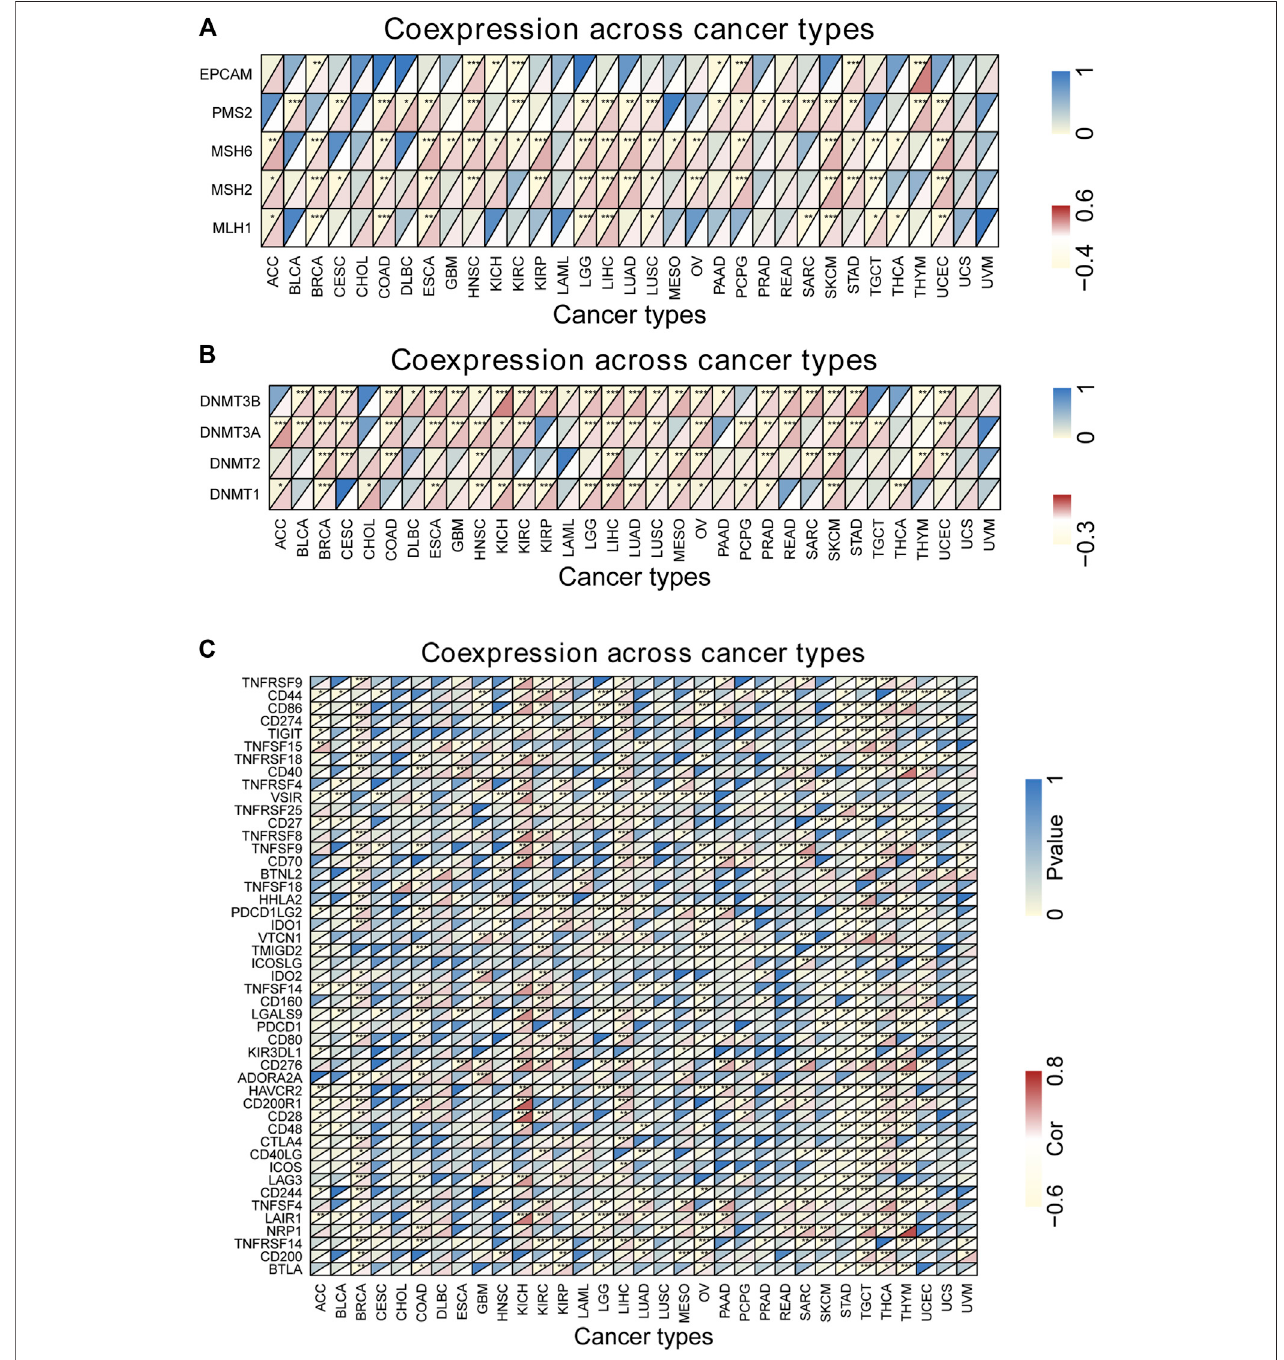
FIGURE 7 | Co-expression analysis between DUXAP8 expression and fi ve mismatch repair genes (A) , DNA methyltransferase (B) and immune genes (C) in cancers.* p < 0.05;** p < 0.01;*** p < 0.001.Cor,correlationcoef fi cient.Thehorizontalaxisrepresentscancertypes,theverticalaxisrepresentsimmunegenes,andeach small rectangular module represents the co-expression of the gene and DUXAP8 in cancer, during them, the upper left corner asterisk and color represent the P-value, and the lower right corner color represents the Cor. * p < 0.05; ** p < 0.01; *** p < 0.001. Cor, correlation coef fi cient.